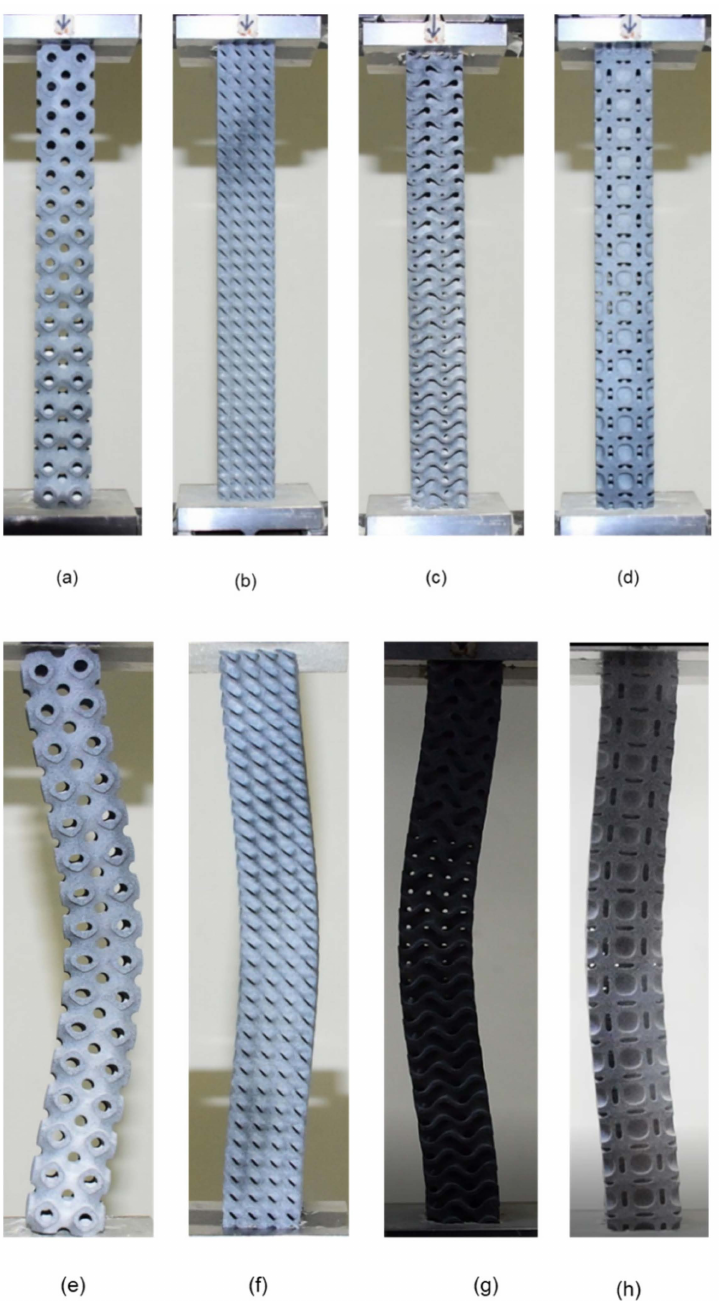
Figure 9. Samples of the 2 × 2 × 16 configuration reduced to 0 percent compression. ( a ) Schwarz- P, ( b ) Diamond, ( c ) Gyroid and ( d ) Neovius. Sample of the 2 × 2 × 16 configuration indicates all samples are buckled only globally; no local buckling is detected. ( e ) Schwarz-P, ( f ) Diamond, ( g ) Gyroid ( h )